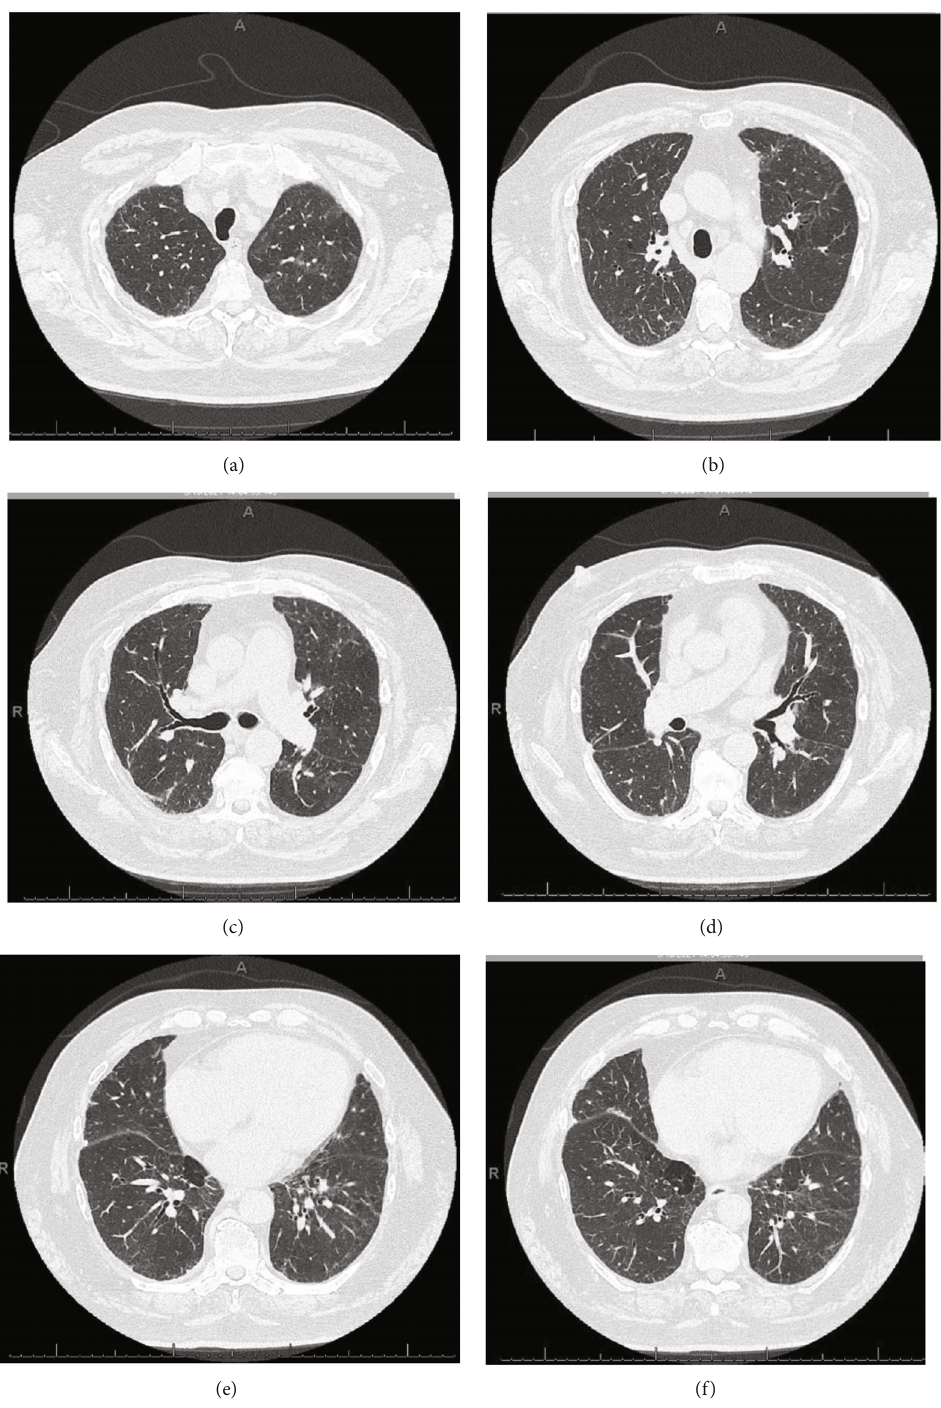
Figure 4: CT scan of the chest with intravenous contrast at 6-month follow-up visit. CT chest images (a) – (f) showing signi fi cant interval improvement of ground glass opacities and interstitial in fi ltrates in the lungs with just a few markings remaining in the lung bases, suggesting interval resolution of the in fl ammatory